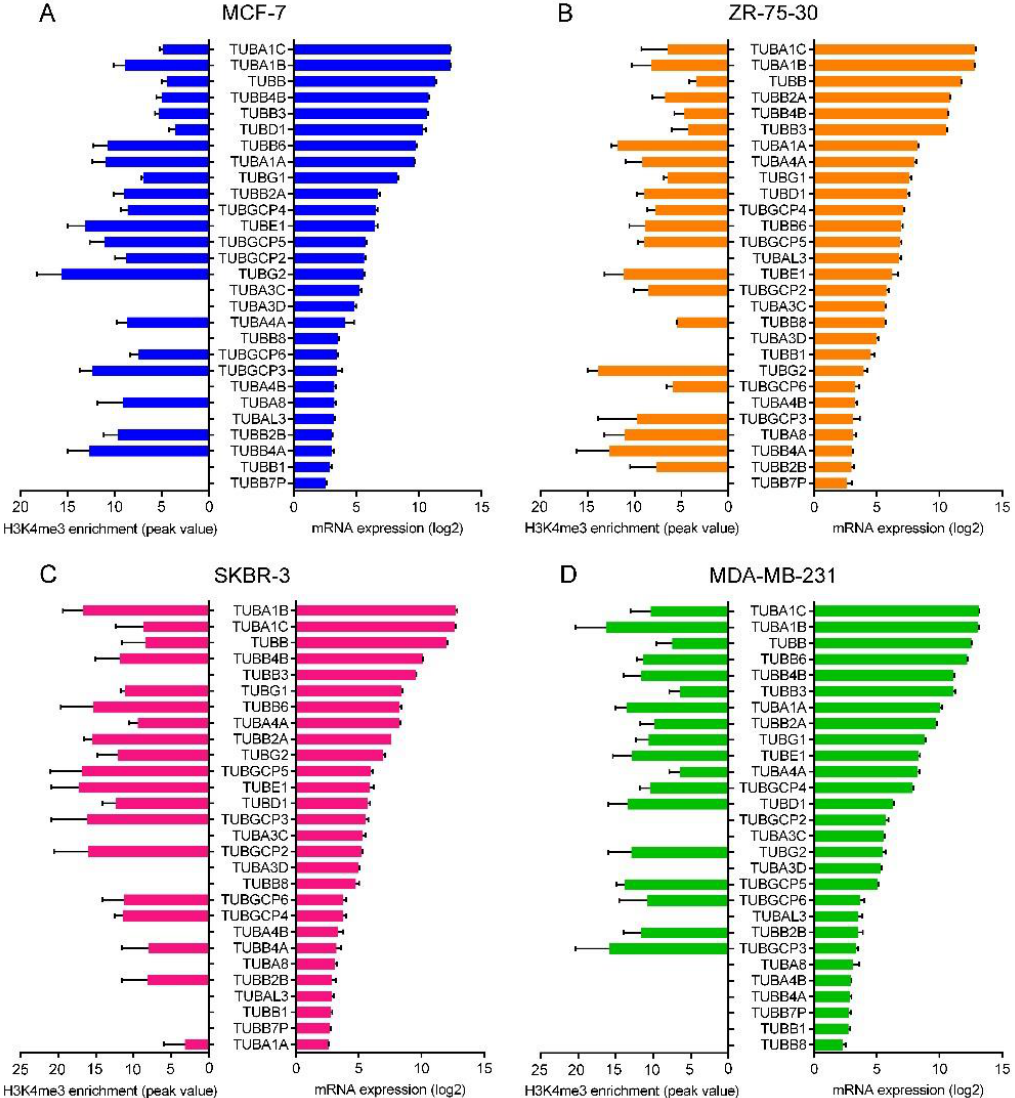
Figure 5. Correlation of promoter activity and expression of the tubulin isoforms. ChIP-seq signal enrichment values of H3K4me3 on the promoter chromatin (left bars) and the mRNA expression (microarray) levels (right bars) of the tubulin genes in ( A ) MCF-7, ( B ) ZR-75-30, ( C ) SKBR-3 and ( D ) MDA-MB-231 cell lines. Data available from GEO datasets with identifiers GSE41313 [67], GSE81714 [72], GSE71327 [73], GSE62966 [74] and GSE49651 [75].